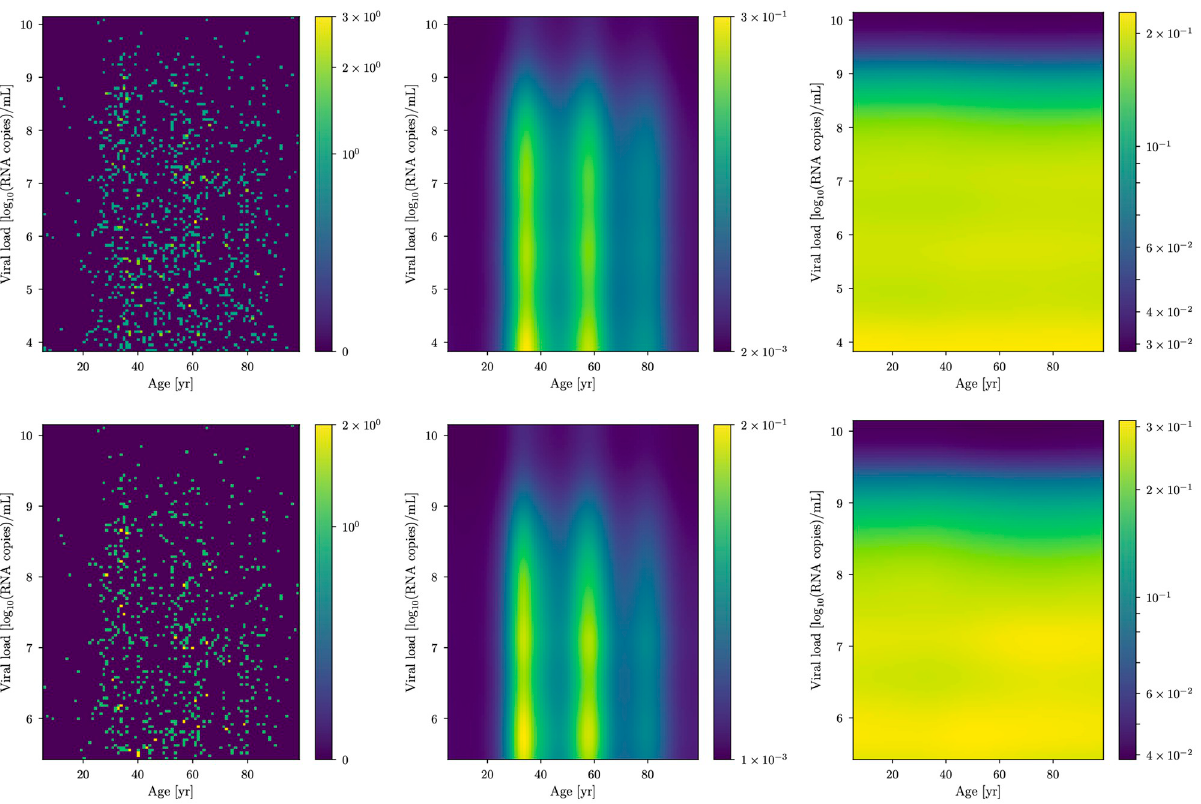
Fig 4. LC 480 dataset analysis. The same as in Fig 3, but for the LC 480 dataset.